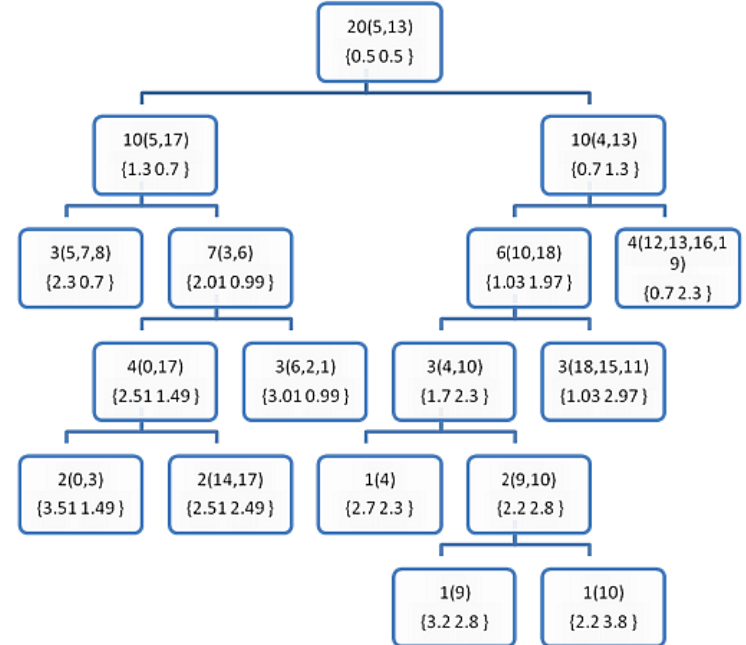
Figure 4. The resultant decision tree after applying the training phase of the DT0+ on the sample data from Table 1. The number outside the rounded brackets is the counter of the examples hosted by each node, and those inside the rounded brackets are the index of the examples in a leaf node, or the furthest points (P1 and P2) otherwise. The numbers in the curly brackets {} shows the probabilities of the classes at each node.